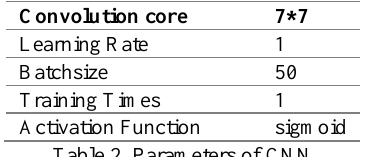
Table 2. Parameters of CNN